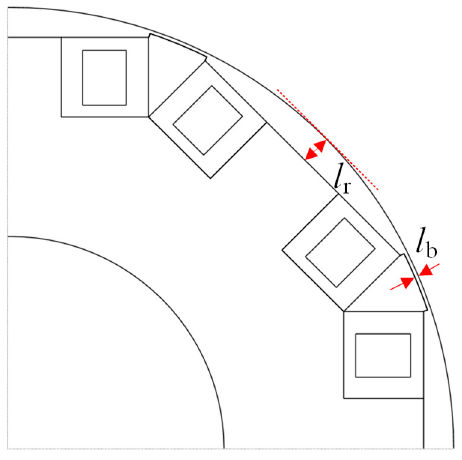
Figure 4. Ferromagnetic ring parameters.